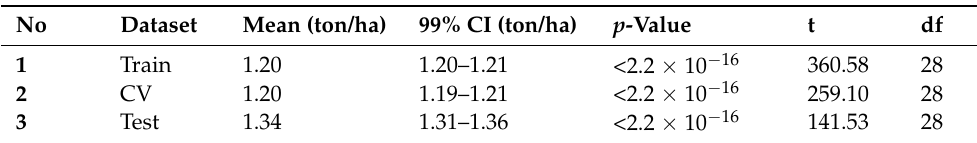
Table 8. Table showing RMSE (ton/ha) values at 99% CI for training, CV, and test datasets for three hidden